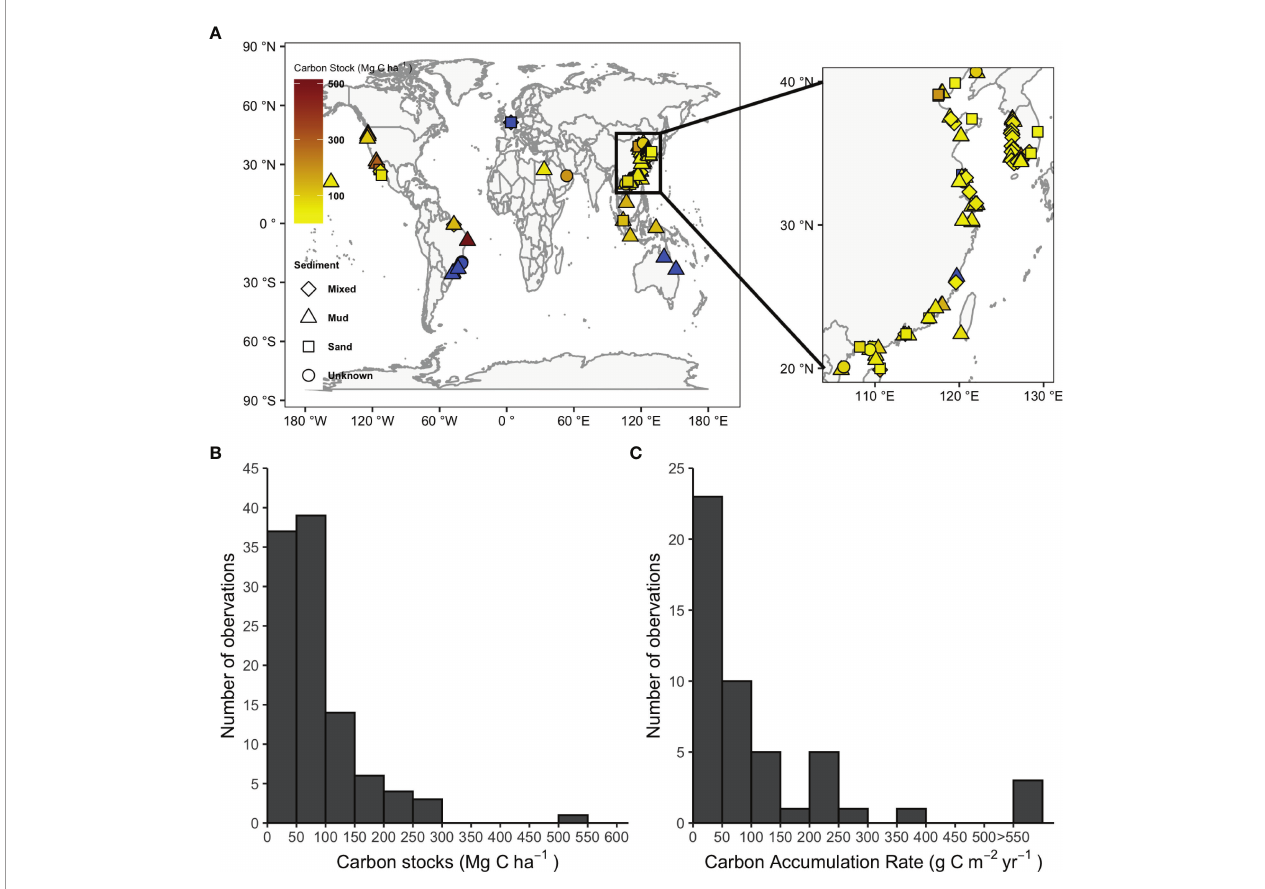
FIGURE 1 | Locations of studies on tidal fl ats sediment C sequestration and frequency histogram of the values of sediment carbon stock and carbon accumulation rate in tidal fl ats. (A) Studies without C stock information are indicated in blue. (B) Sediment carbon stock from 104 sites; (C) Carbon accumulation rate from 49